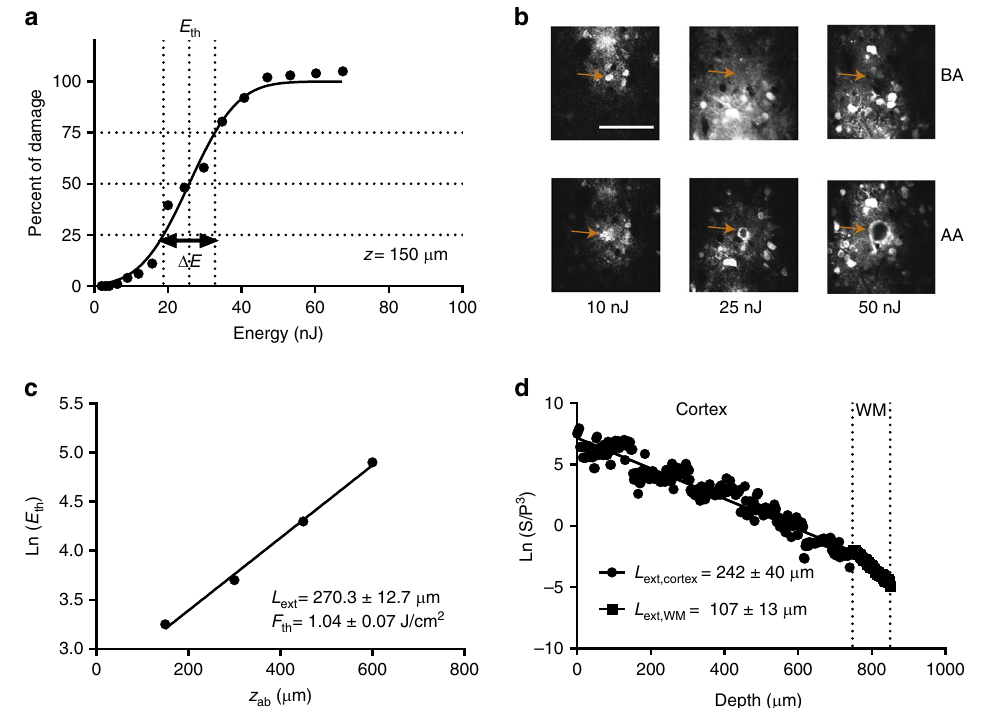
Fig. 2 Characterization of optical properties of live mouse cortex at 1300 nm excitation wavelength. a Determining extinction length via tissue ablation. Percent of damage ranges from 0 to 100% with respect to laser energy on the tissue surface. Threshold energy ( E th ) is the energy which results in 50% damage. For ablation at 150 µ m depth, E th is 25.7 nJ. b Representative images before ablation (BA) and after ablation (AA) for three pulse energies (10, 25 and 50 nJ) at 150 µ m depth. Arrows show the location of target region for the ablation before and after applying laser pulses for each pulse energy. c Semi- logarithmic plot of threshold energies for 4 different depths results in extinction length ( L ext ) of 270.3 ± 12.7 µ m and threshold fl uence ( F th ) of 1.04 ± 0.07 J/cm 2 . d Semi-logarithmic plot for ratio of PMT signal (S) and cube of laser power ( P ) with respect to imaging depth for third harmonic generation (THG) imaging. Slope of this curve results in 242 ± 40 µ m extinction length for the cortex ( L ext,cortex ), and 107 ± 13 µ m extinction length for the white matter ( L ext, µ m in depth. Scale bar in ( b ) represents 100 µ m. Values shown are mean ± WM ). Laser power was increased by two-fold every 150